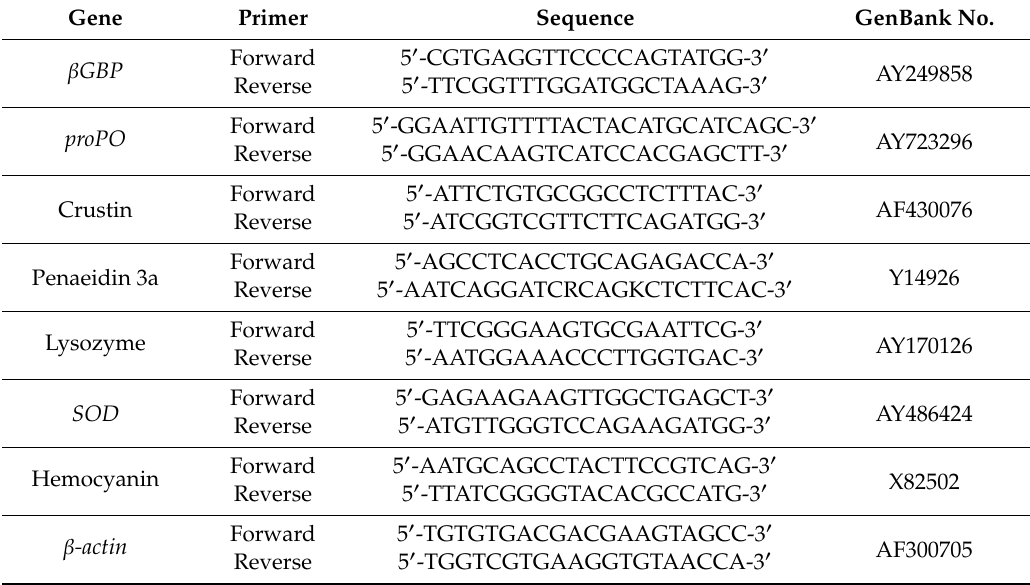
Table 1. Information of target genes and primers for monitoring the expression level of genes related to antimicrobial peptides and the immune defense system against major pathogens. Gene Primer Sequence GenBank No. β